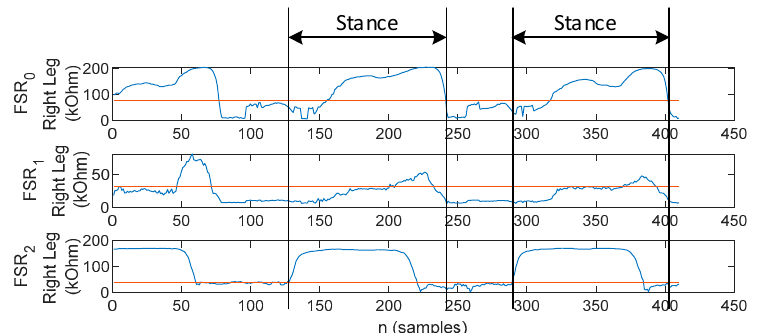
Figure 11. Illustration of the procedure for stance identification: the stance phase lasts from the first to the last occurrence of plantar pressure, identified by having the FSR signals compared to an empirical threshold level.